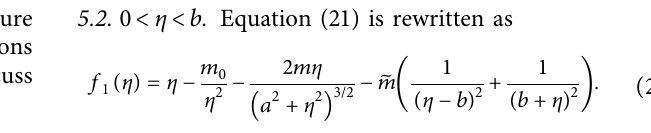
Figure 7: The permitted (white) and prohibited (shaded) regions of motion of m (a) C � − 2 . 59, (b) C � − 2 . 47, (c) C � − 1 . 97, (d) C � − 1 . 64, (e) C � − 1 . 57, and (f) C � − 1 .